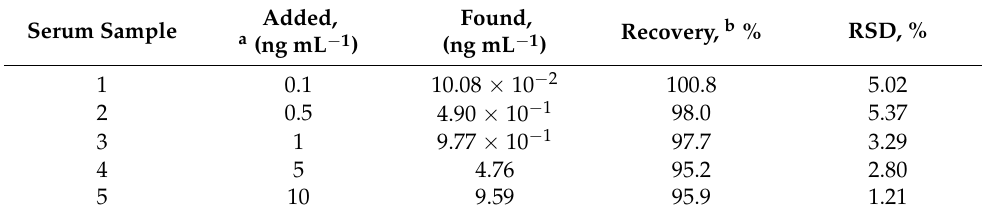
Table 1. Assay results of real human serum by proposed μ PAD. Serum Sample